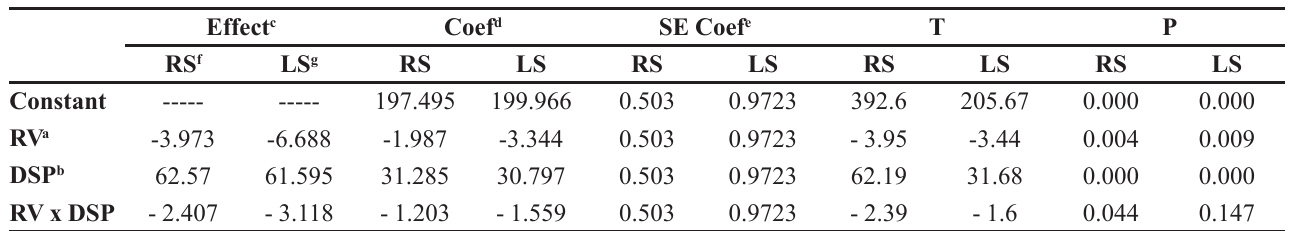
TABLE III - Estimated effects and coefficients for mean